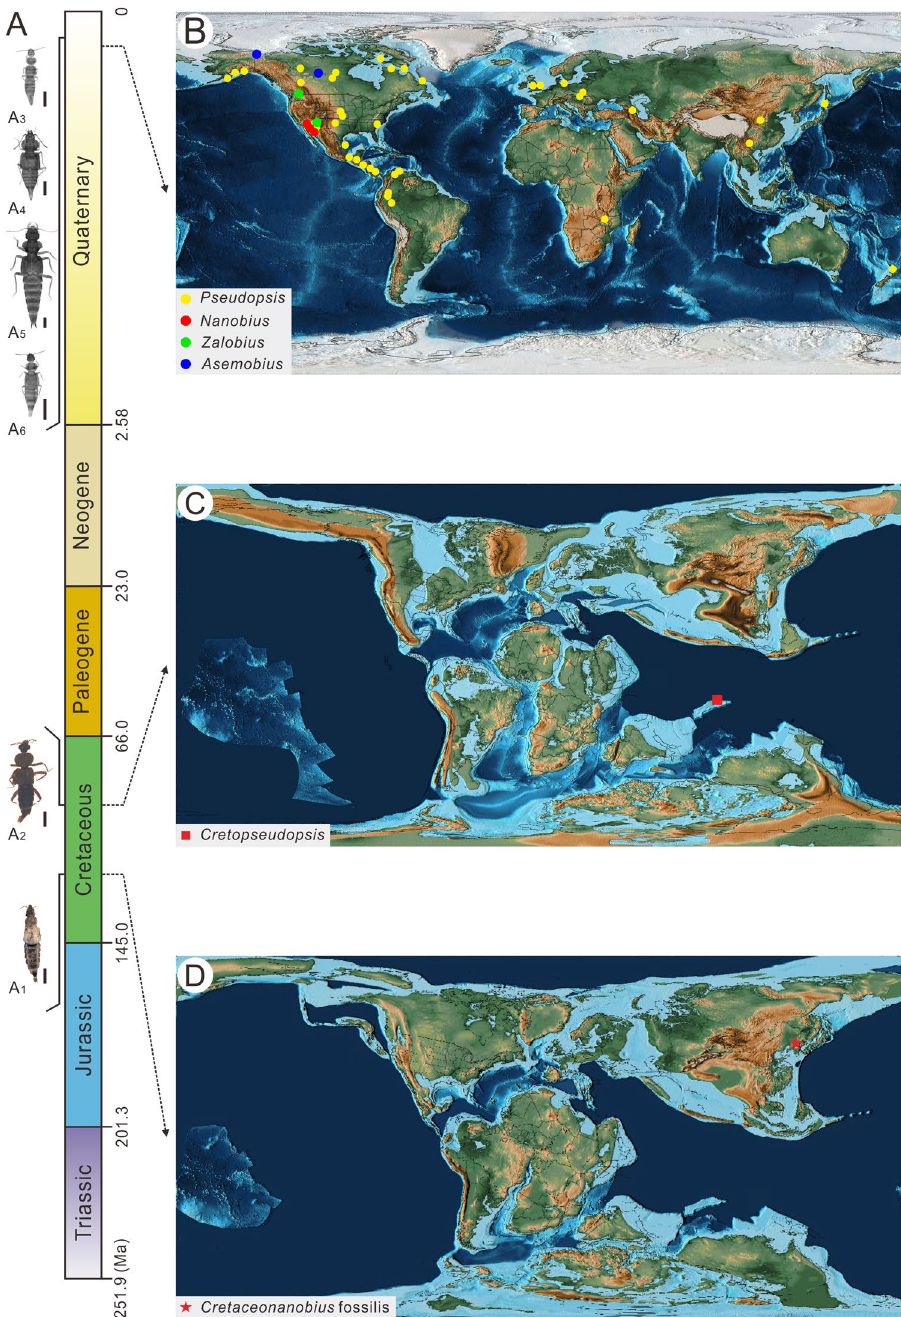
Figure 5. Distribution of extinct and extant Pseudopsinae taxa. ( A 1 ) Cretopseudopsis maweii , ( A 2 ) Cretaceonanobius fossilis gen. et sp. nov., ( A 3 ) Pseudopsis , ( A 4 ) Asemobius , ( A 5 ) Nanobius , ( A 6 ) Zalobius . Scale bars = 500 μm. ( B ) Recent geographic map after Scotese 57 : yellow, red, green and blue dots show the distribution of Pseudopsis , Nanobius , Zalobius and Asemobius , respectively; ( C ) Palaeogeographic map of the Early Cretaceous after Scotese 57 , with the red square for Cretopseudopsis maweii ; ( D ) Palaeogeographic map of the Early Cretaceous after Scotese 57 , with the red star indicating the distribution of the Cretaceonanobius fossilis gen. et sp.